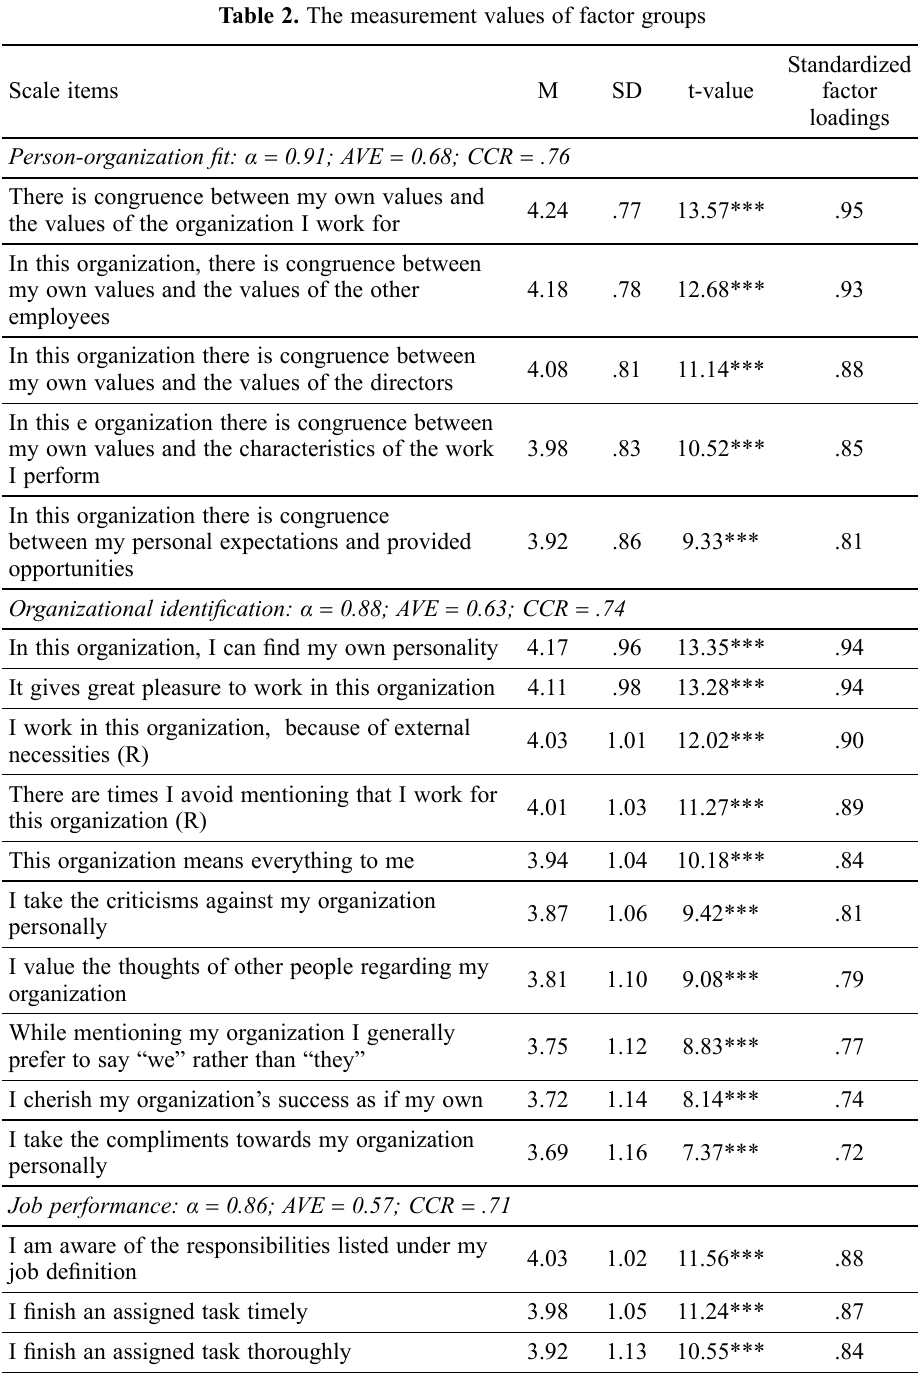
Table 2. The measurement values of factor